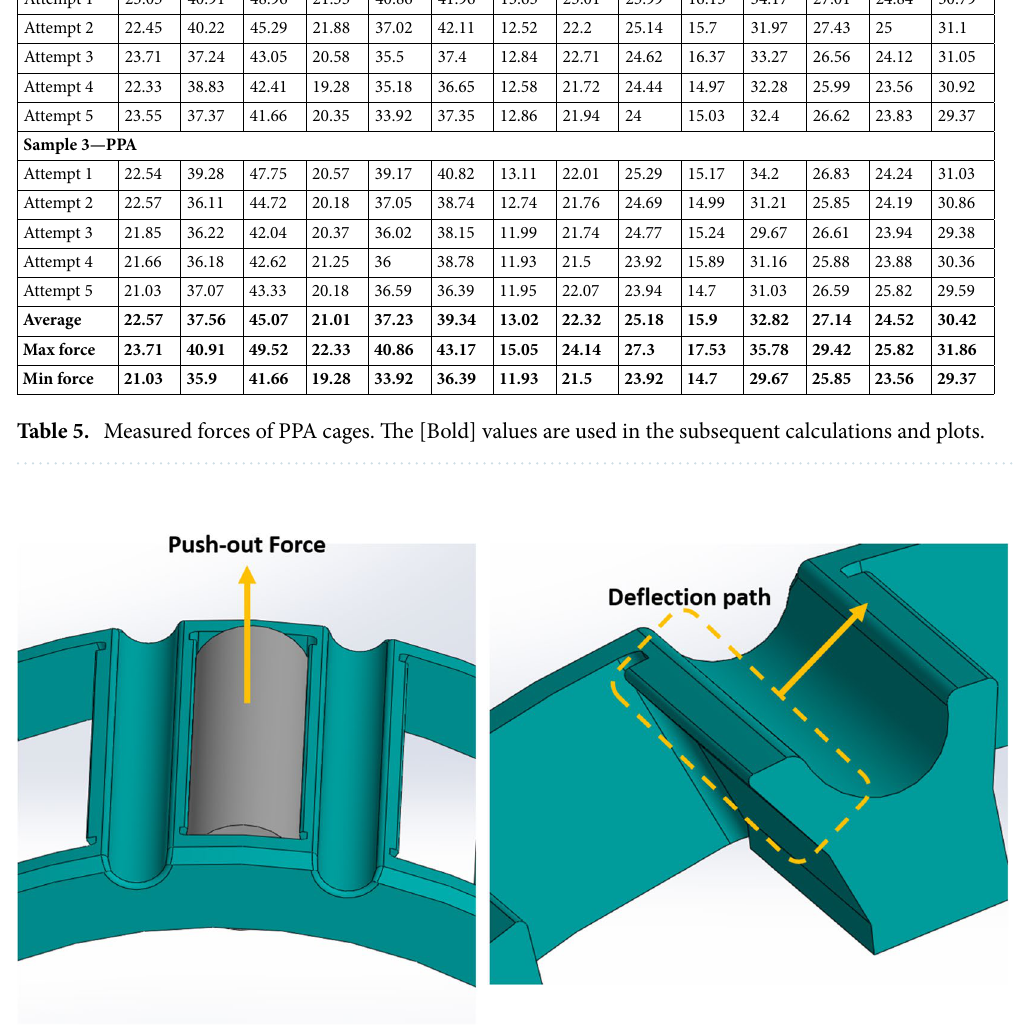
Figure 6. Push-out force and deflection path